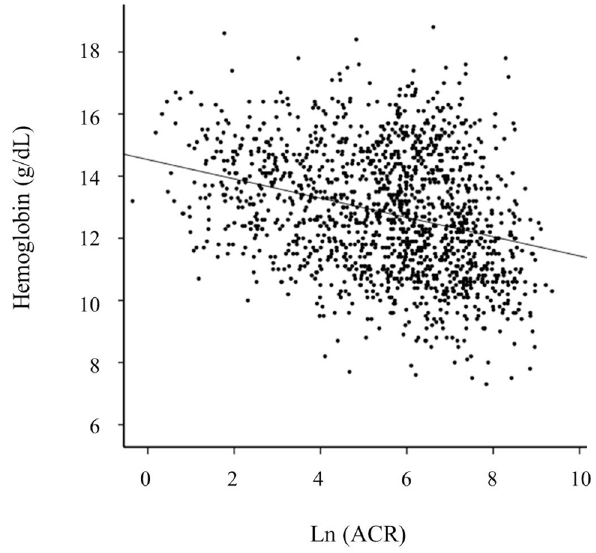
Fig 1. Correlation of hemoglobin levels with albuminuria. Hemoglobin levels are inversely related with Ln ACR levels (r = -0.281, P < 0.001). Abbreviation : ACR, albumin-to-creatinine ratio; Ln ACR, log-transformed albumin-to-creatinine ratio